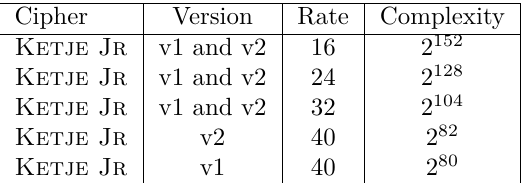
Table 1: Complexities of our divide-and-conquer attack with nonlinear sieving